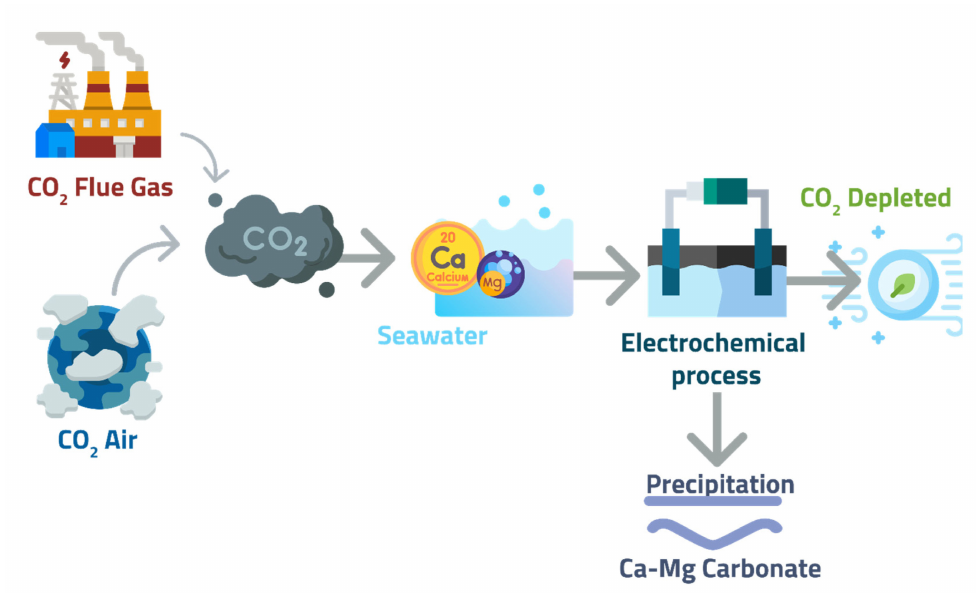
Figure 12. A schematic of localized OH − generation on membrane surfaces using the electrochemical process to induce carbonate